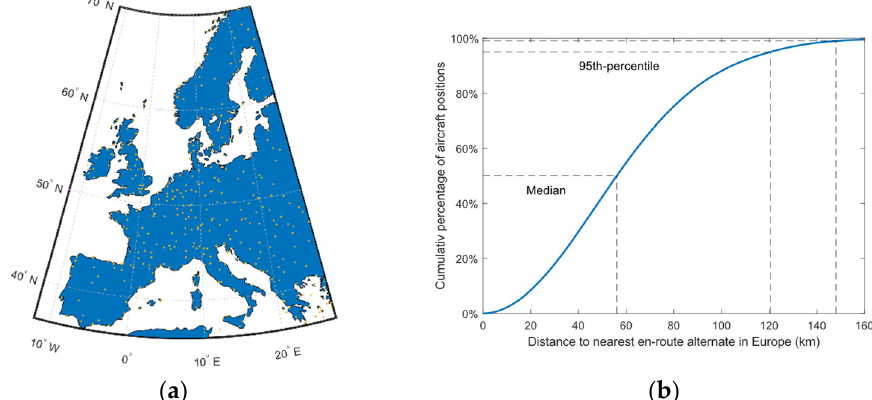
Figure 11. Possible alternate airports ( a ) and plot of cumulative frequency of the distance to a suitable en route alternate with a concrete or asphalt runway ( b ).